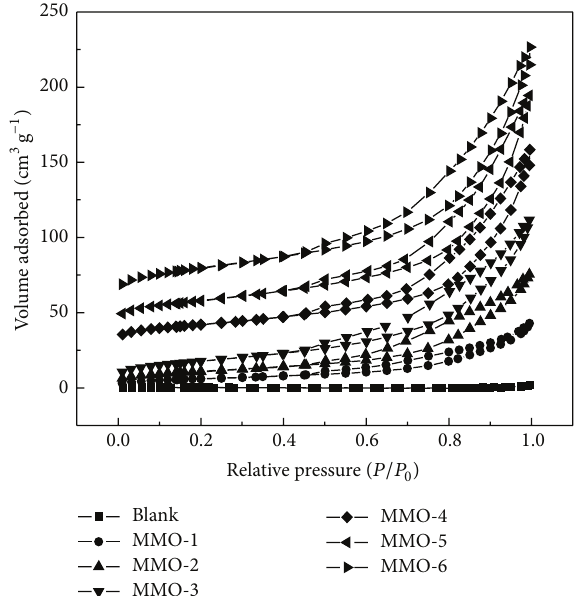
Figure 3: Adsorption and desorption isotherms of the samples of blank and MMO- 𝑥 ( 𝑥 = 1–6). The isotherms of MMO-4, MMO-5, and MMO-6 were offset vertically by 25, 35, and 55 cm 3 g −1 STP.